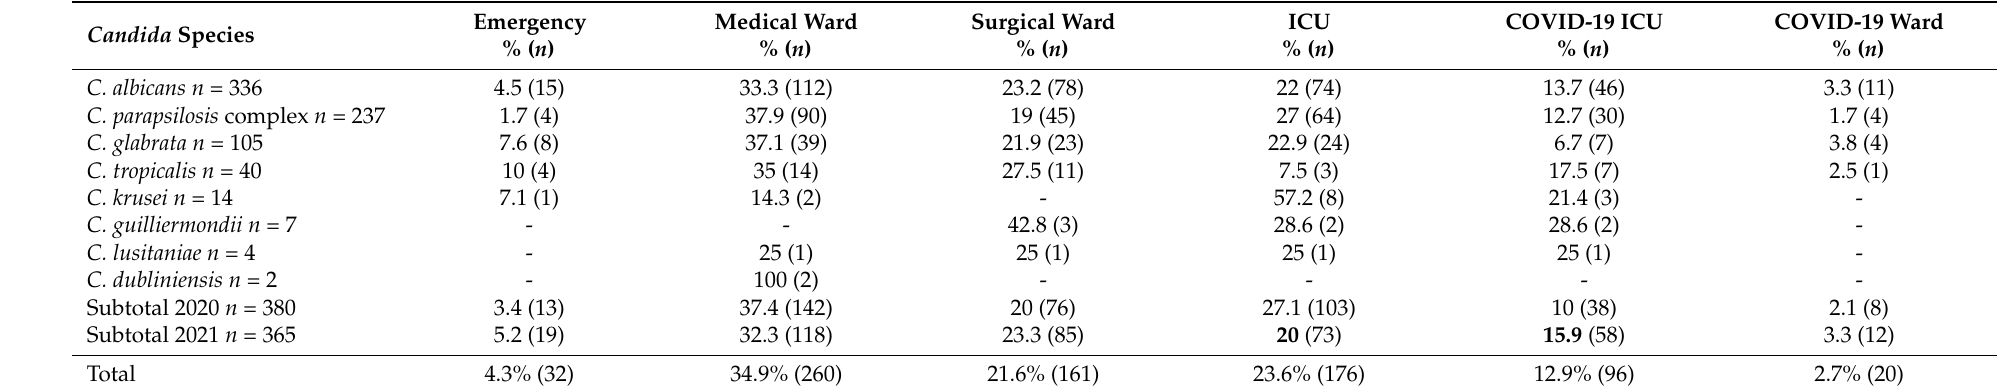
Table 2. Distribution per year of Candida species according to hospital